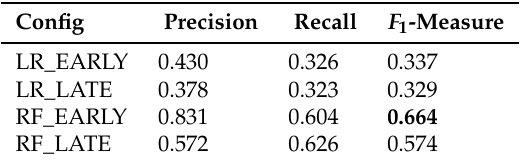
Table 7. Overall performance of different classifiers using early and late fusion. Late fusion dropped in this scenario.